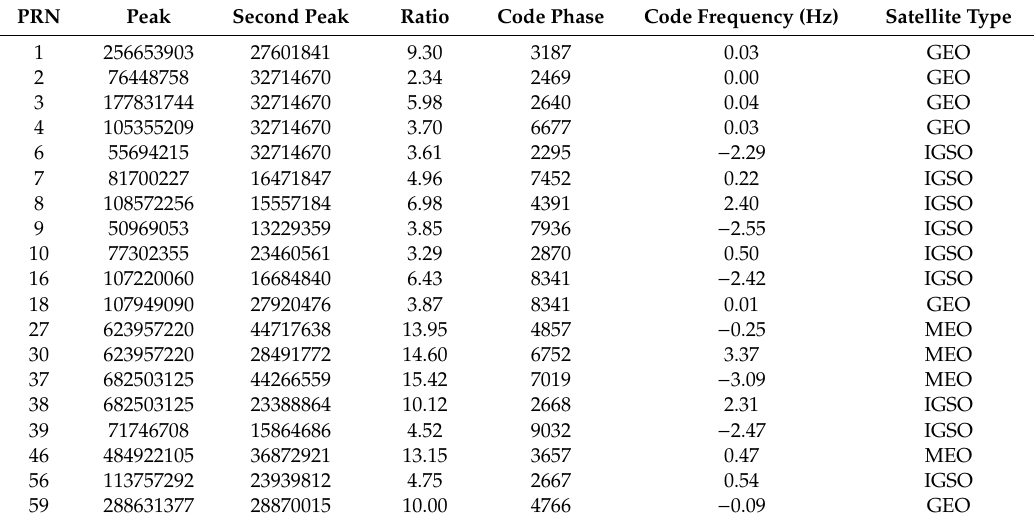
Figure 9. The hardware components of the BeiDou software-defined recever front end based on universal software-radio peripheral (USRP). Table 5. The actual acquisition results of BeiDou B1 signal.